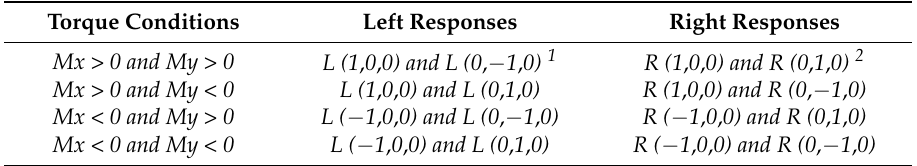
Table 2. Orientation adjusting